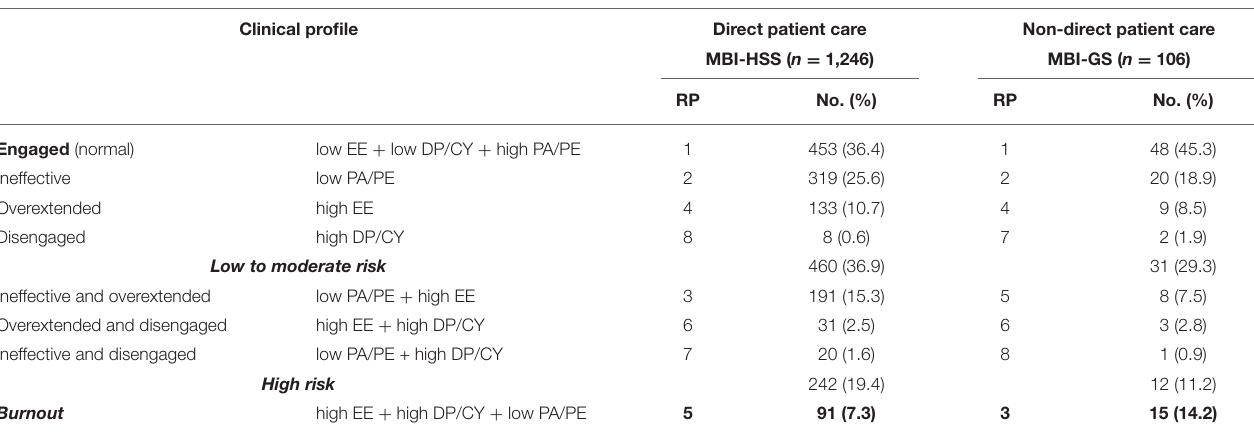
TABLE 3 | Distribution of participants by clinical profile and burnout risk. Clinical